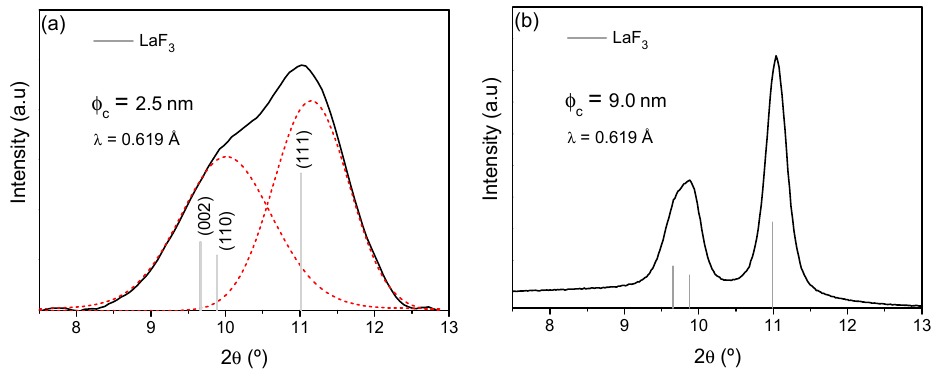
Figure 5. ( a ) Grazing incidence XRD (GI-XRD) of thin film and ( b ) XRD of the bulk sample of composition 80SiO 2 -20LaF 3 0.5Er 3+ (TEOS-MTES) treated at 550 °C for 1 min. The crystal size is given together with the LaF 3 reference shown with vertical bars (JCPDS 00-032-0483).